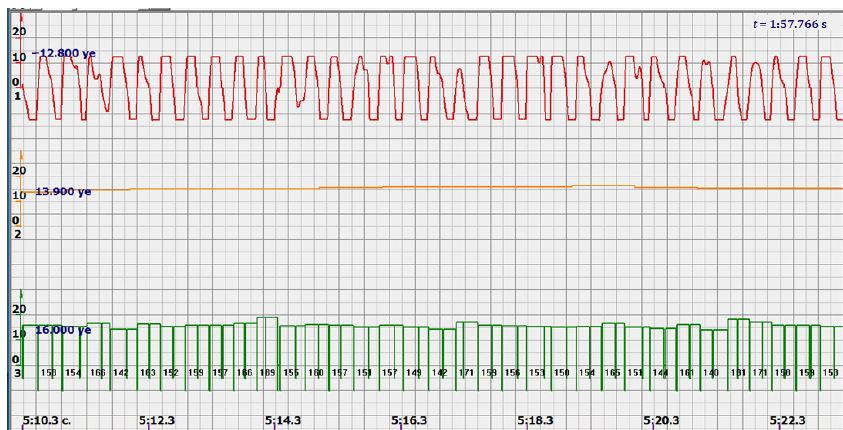
Figure 15. Heart rate—from 142 to 189 bpm.